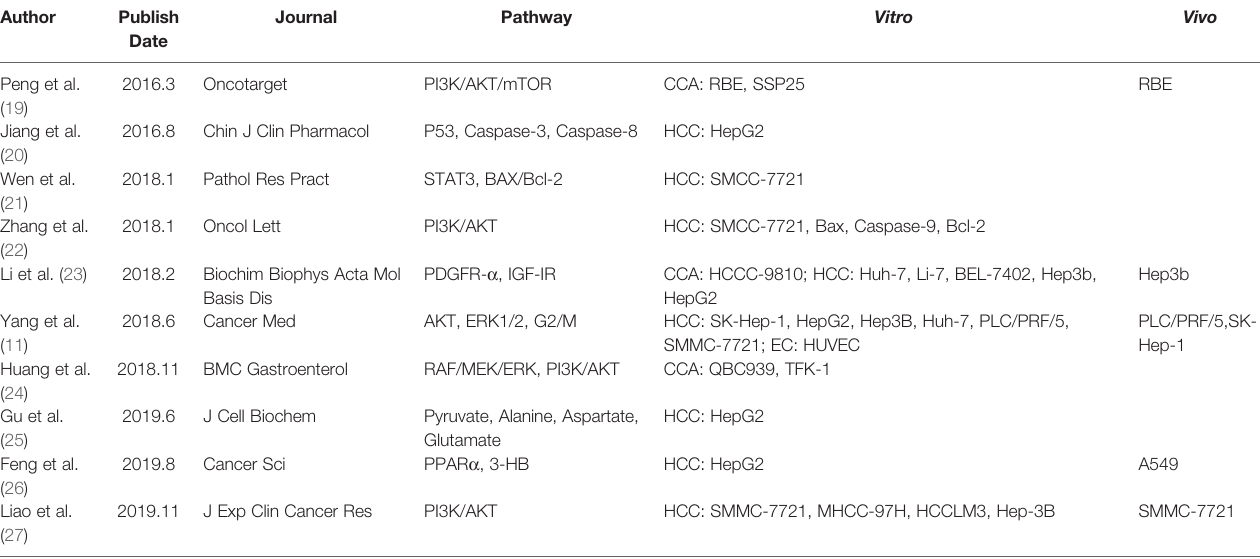
TABLE 2 | Pathways underlying the anticarcinogenic effect of apatinib on liver